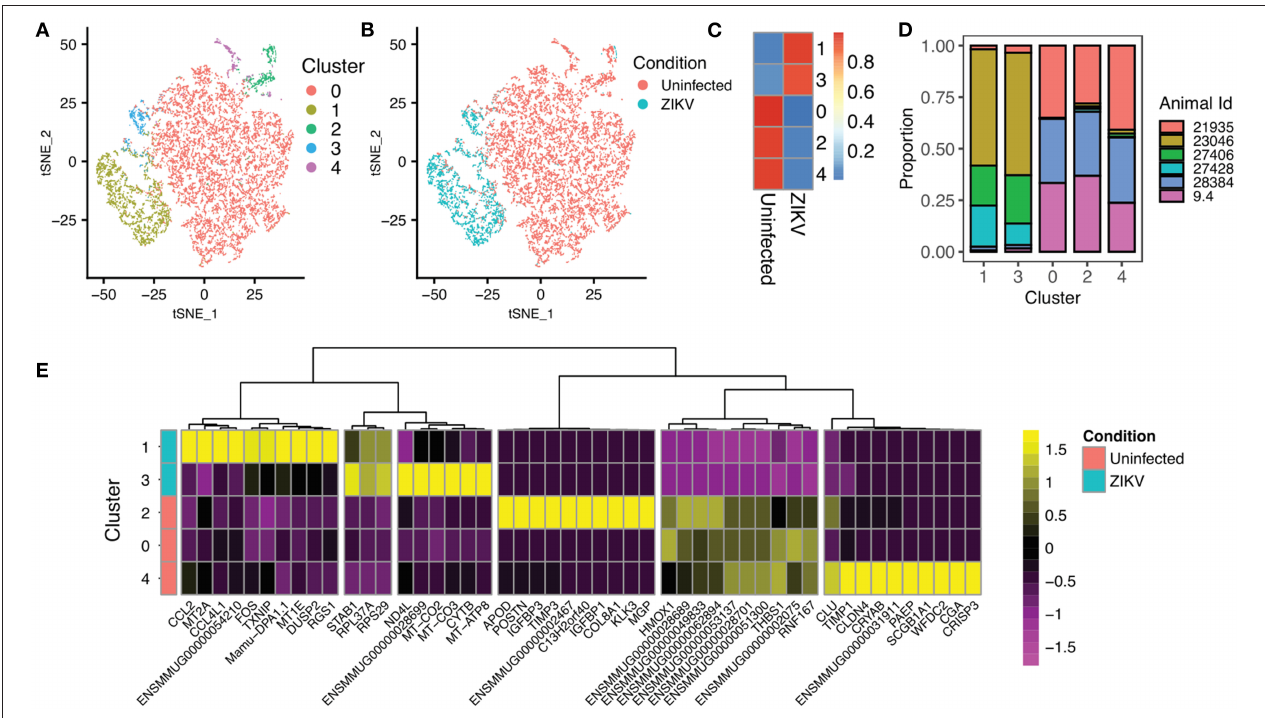
FIGURE 2 | Single-cell RNA sequencing of CD14 + cells from the placenta of ZIKV and uninfected RM. (A) Unsupervised clustering of single-cell transcriptomes from 11,752 CD14 + placental monocytes. Cells are colored based on cluster assignment. (B) Identical dimensionality reduction as (A) , with cells colored by the ZIKV of the RM, with cells from ZIKV-infected RM colored blue, and cells from uninfected controls colored red. (C) The heat map illustrates the proportion of cells from ZIKV vs. uninfected RM in each cluster. There is very little overlap between cells from ZIKV-infected and uninfected animals. (D) Contribution of samples to each cluster. (E) Heatmap showing the top differentially expressed genes for each cluster. Clusters 1 and 3 (top) are primarily from ZIKV-infected animals. Clusters 0, 2, 4, and 5 are primarily from uninfected